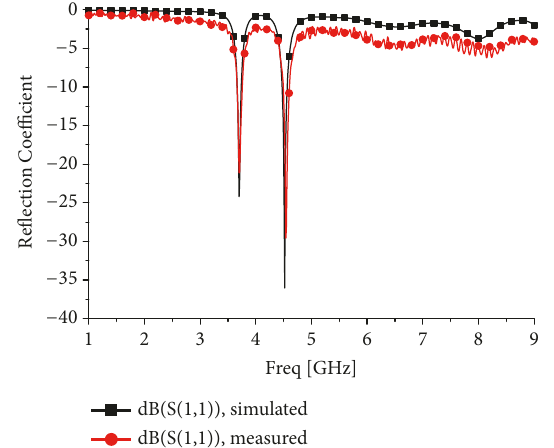
Figure 12: Simulated and measured reflection coefficients of the proposed